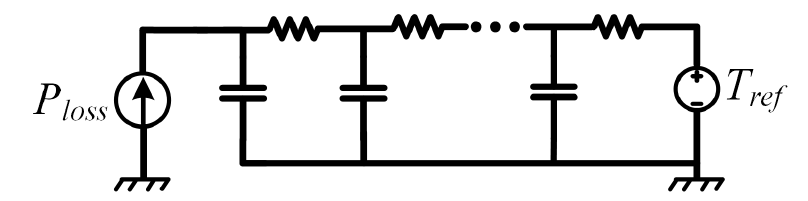
Figure 9. Cauer model representation for power electronics temperature